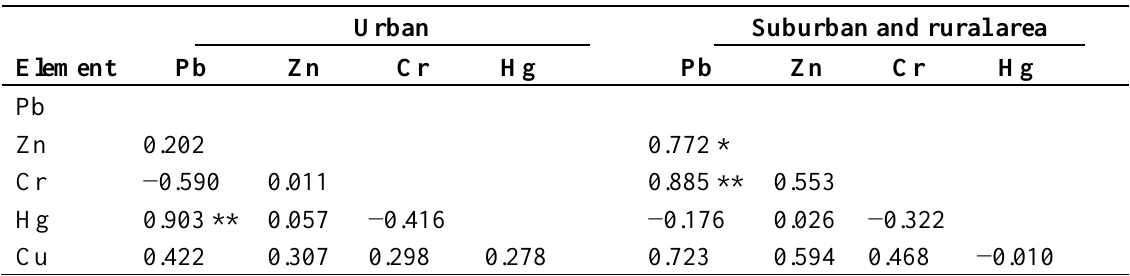
Table 4. Pearson’s correlation matrix for the metal concentrations of top- layer of soil. Urban Suburban and rural area Element Pb Zn Cr Hg Pb Zn Cr Hg Pb Zn 0.843 * 0.045 Cr −0.767 * −0.397 0.634 0.543 Hg 0.874 * 0.892 ** −0.606 0.240 0.363 0.318 Cu 0.888 ** 0.939 ** −0.608 0.857 * 0.570 0.124 0.818 * 0.209 The left lower part is the correlation coefficient; the right upper part is the significance level.